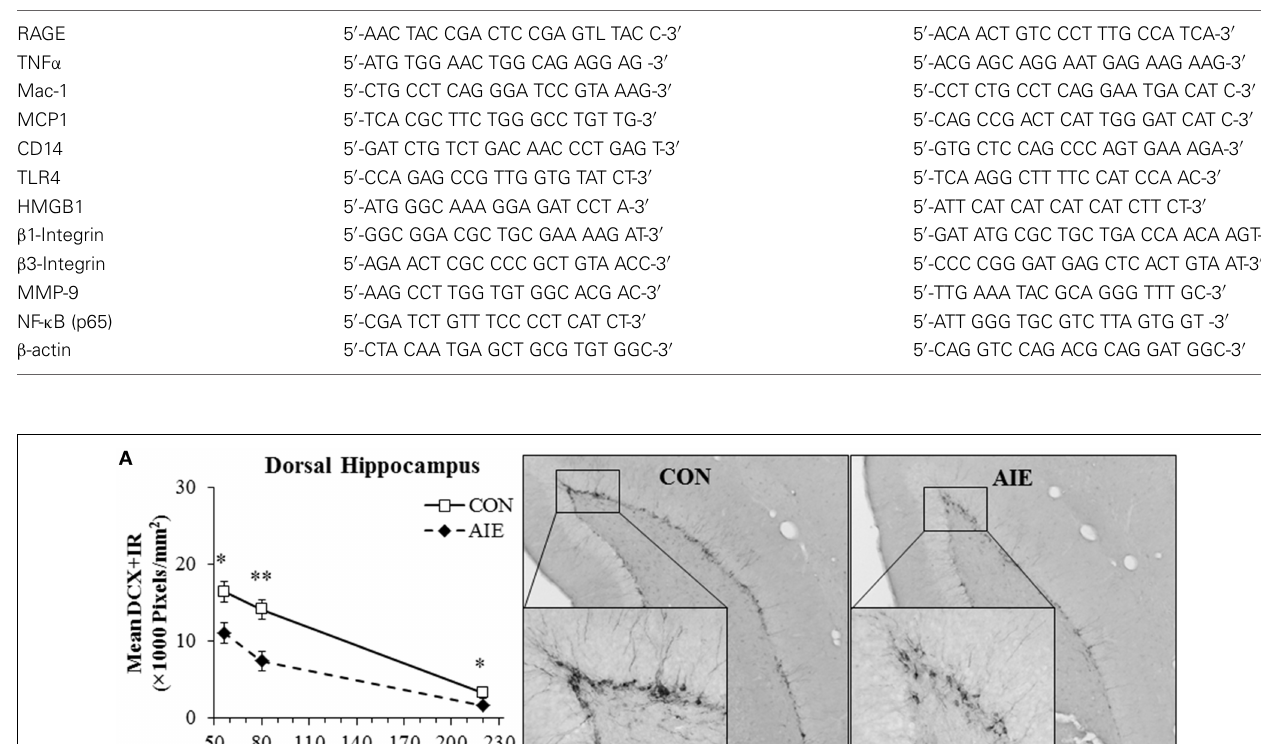
Table 1 | List of primers for RT-PCR. Primer